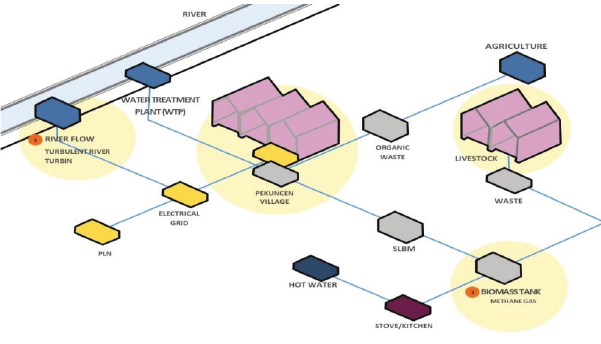
Figure 5. The schematic diagram of renewable energy in